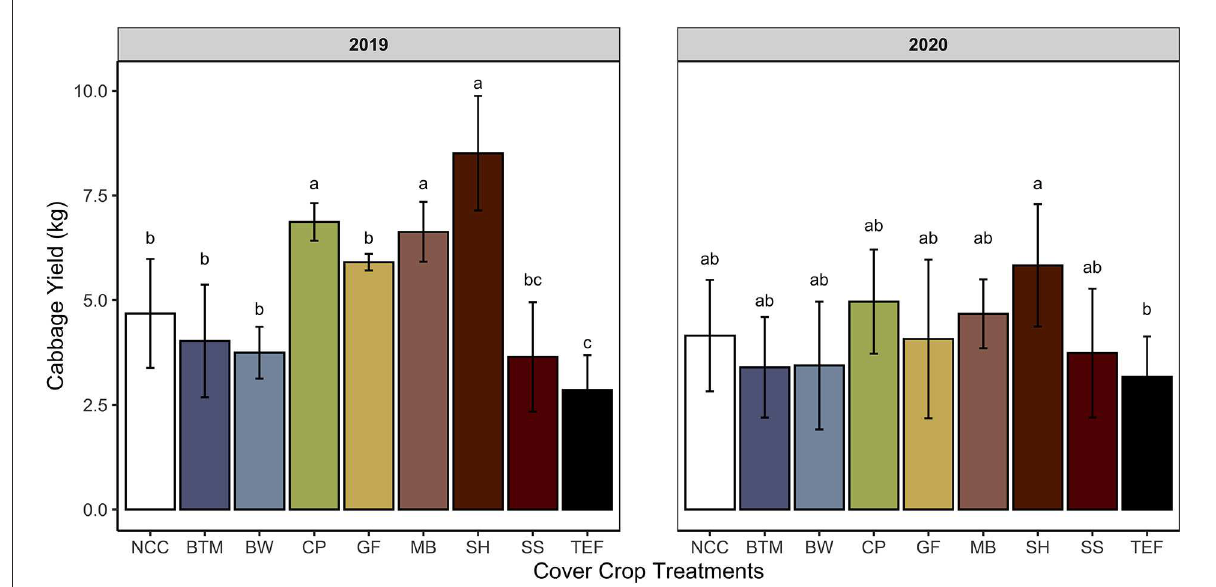
FIGURE4 Total cabbage yields by summer cover crop. Means and standard deviations shown for treatments: NCC, no cover crop (Control); BTM, brown top millet; BW, buckwheat; CP, cowpea, GF, golden flax; MB, mung bean; SH, sunnhemp; SS, sorghum sudangrass; TEF, teff. Values with different letters indicate significant differences according to Tukey’s HSD P < 0.05. Single degree of freedom contrasts performed: Legumes vs. grasses, Legumes vs. NCC, grasses vs. NCC, and forbes vs. NCC (2019 P -values < 0.0001, 0.0008, 0.3518, and 1.000. 2020 P -values 0.002, 0.4793, 0.7851, and 1.000,